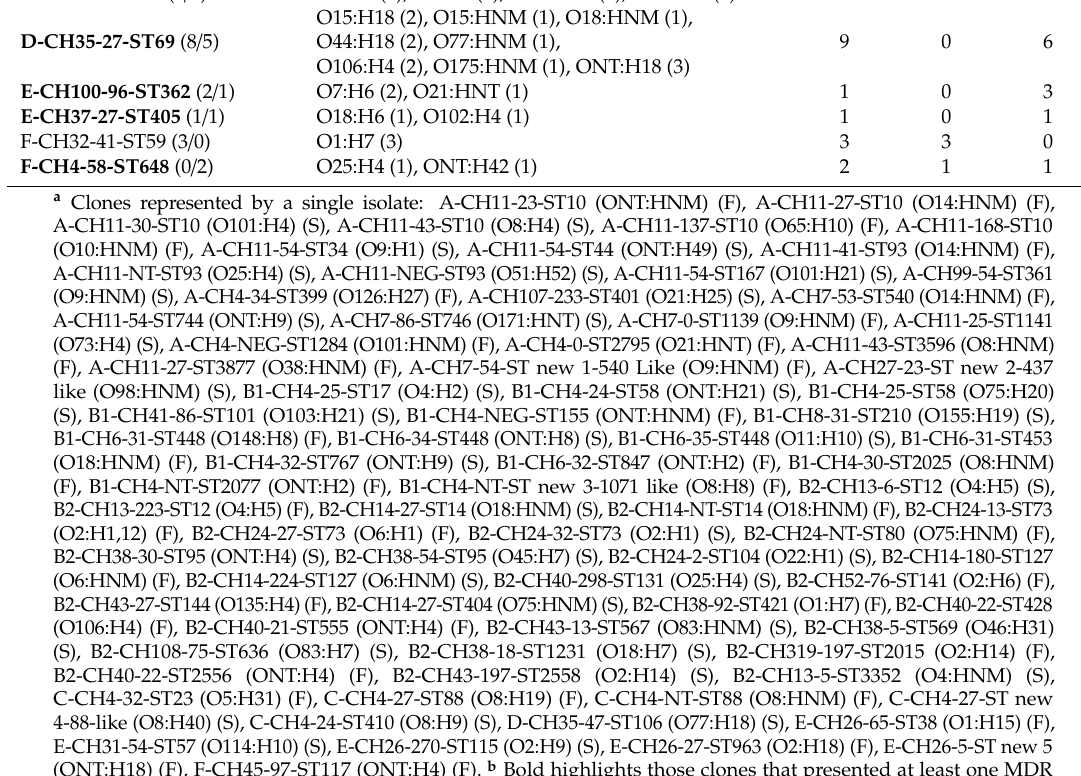
Table 1. Clones, serotypes, and extraintestinal pathogenic E. coli (ExPEC), uropathogenic E. coli (UPEC), and multidrug resistant (MDR) status of the 196 isolates. Clone (Number of Isolates from Spain and France) a,b